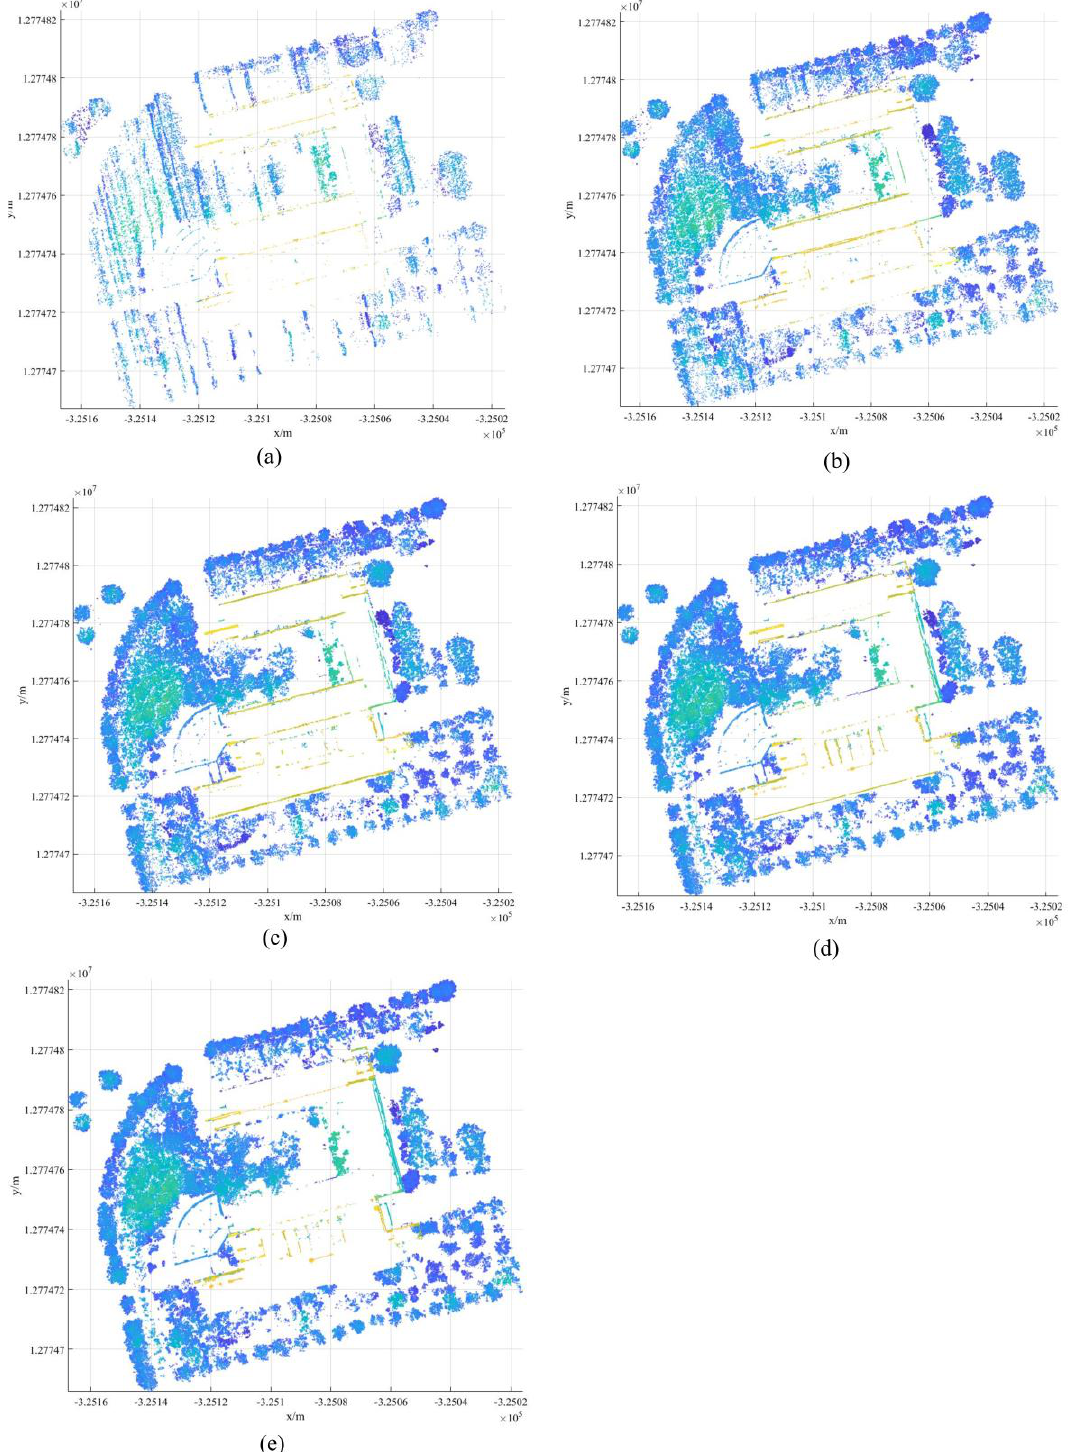
Figure 6. Vegetation extraction results at different R- neighborhood scales in plot 1. ( a ) R = 0.2 m; ( b ) R = 0.4 m; ( c ) R = 0.6 m; ( d ) R = 0.8 m; ( e ) R = 1 m.